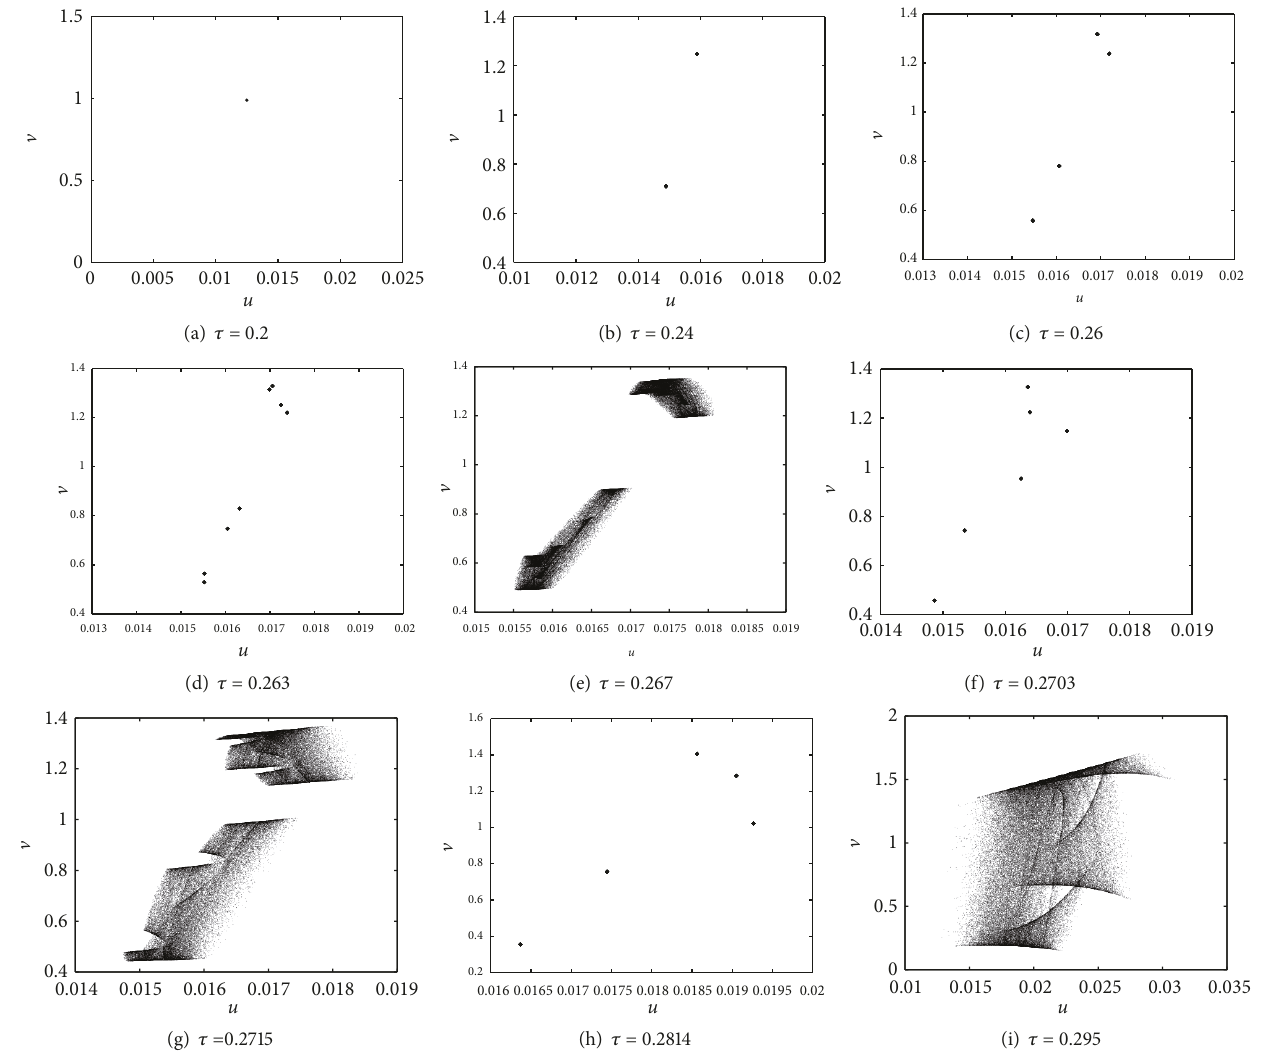
Figure 3: Phase diagrams for different values of parameter 𝜏 corresponding to Figure 1(a).